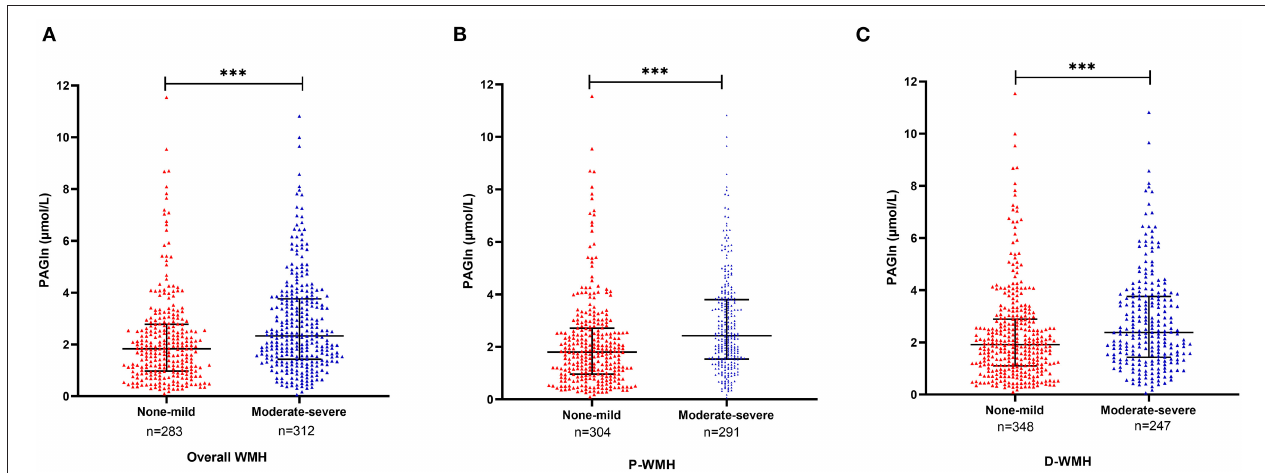
FIGURE 1 | Plasma PAGln levels in different groups according to the severity of WMH. (A) Patients with moderate–severe overall WMH had higher plasma PAGln levels than patients with none–mild overall WMH [median 2.3 (IQR 1.5–3.8) vs. median 1.8 (IQR 1.0–2.8) µ mol/L, P < 0.001]. (B) Patients with moderate–severe P-WMH had higher plasma PAGln levels than none–mild P-WMH group [median 2.4 (IQR 1.5–3.8) vs. median 1.8 (IQR 1.0–2.7) µ mol/L, P < 0.001]. (C) Patients with moderate–severe D-WMH had higher PAGln levels than none–mild D-WMH group [median 2.4 (IQR 1.5–3.8) vs. median 1.9 (IQR 1.1–2.9) µ mol/L, P < 0.001]. Horizontal lines represent median and interquartile ranges. WMH, white matter hyperintensity; PAGln, phenylacetylglutamine; P-WMH, periventricular white matter hyperintensity; D-WMH, deep white matter hyperintensity. Mann–Whitney U test, *** P < 0.001.